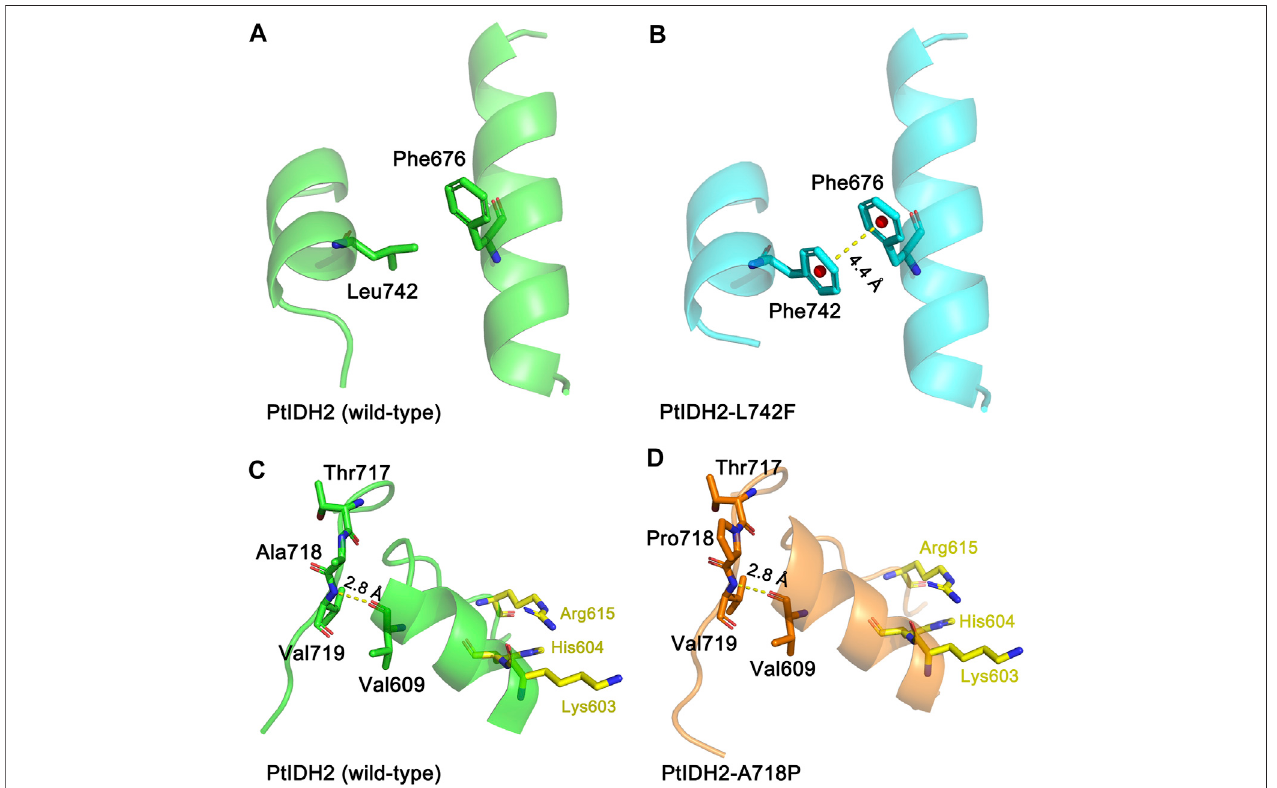
FIGURE 6 | Molecular models of wild-type and mutated PtIDH2. (A) The locations of Leu742 and Phe 676 in wild-type PtIDH2. (B) The locations of Phe742 and Phe676 in the L 742 F mutant. The yellow dashed line shows an aromatic – aromatic interaction at a distance of 4.4 Å. (C) The locations of Thr717, Ala718, Val719, and Val609 in wild-type PtIDH2. (D) The locations of Thr717, Pro718, Val719, and Val609 in the A 718 P mutant. The yellow dashed line shows a hydrogen bond with a length of 2.8 Å. The PtIDH2model and that ofits mutantswere built by the SWISS-MODEL web-serverusing the A. vinelandii isocitrate dehydrogenase (IDH) (PDB code: 1ITW) as a